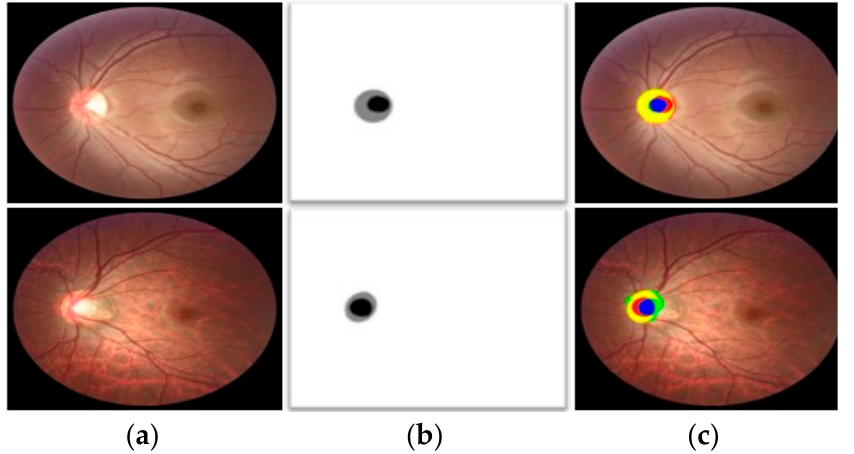
Figure 7. Poor OC and OD segmentation qualitative sample results on the REFUGE database, attained by applying FEDS-Net. ( a ) Input image, ( b ) corresponding groundtruth image, and ( c ) segmented output images (tp pixels for OD and OC are indicated in yellow and blue, respectively. Likewise, red and green show fn and fp pixels, respectively).